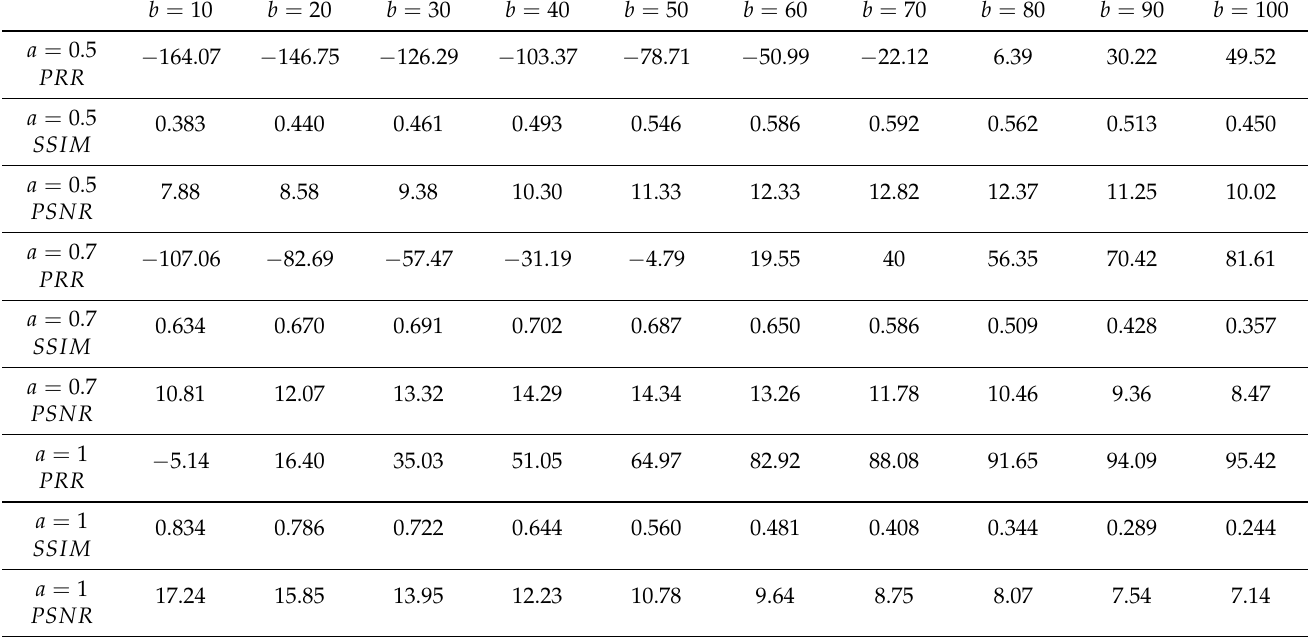
Table 4. Lena image performance metrics with HE for a = { 0.5,0.7,1 } and b =